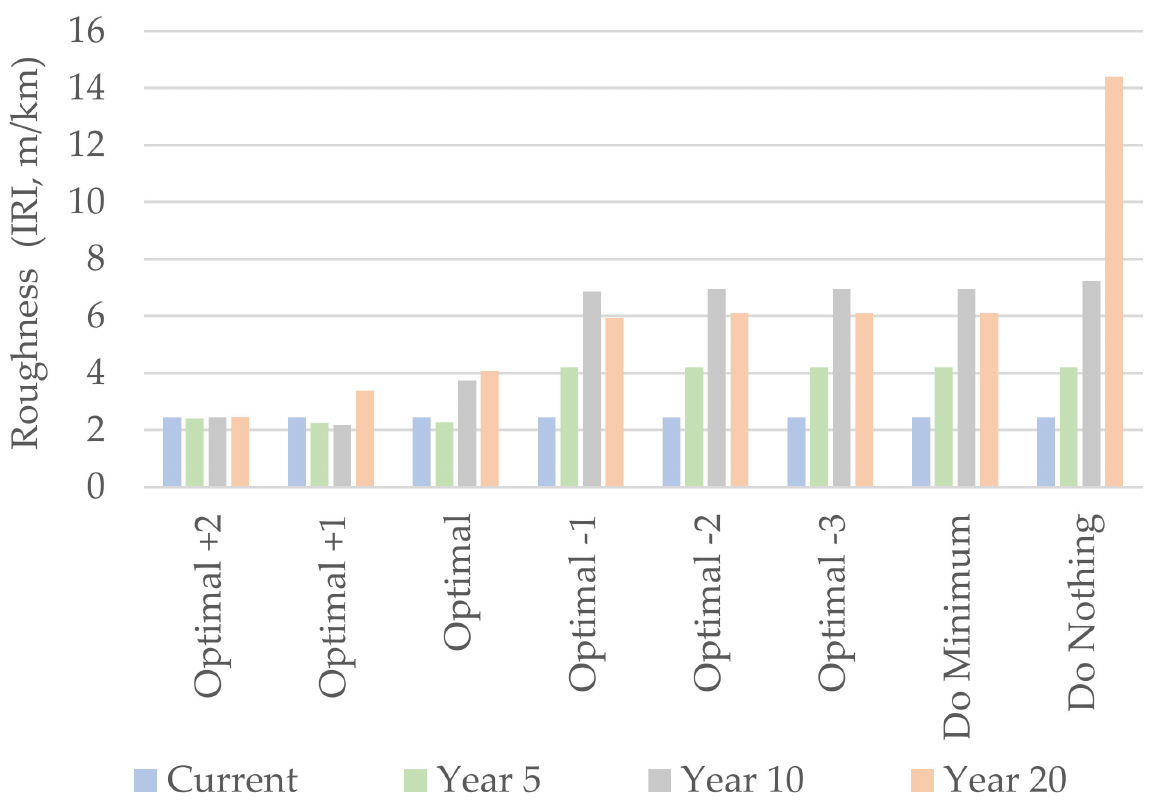
Figure 2. Road deterioration under different